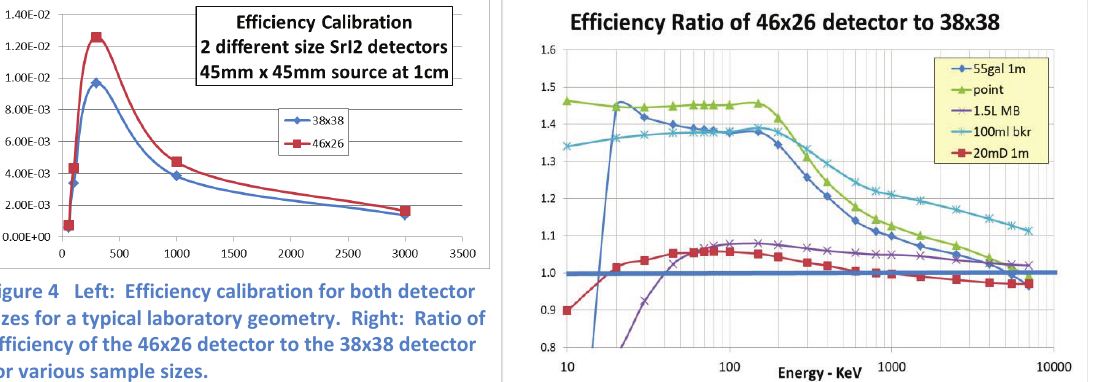
Figure 4 Left: Efficiency calibration for both detector sizes for a typical laboratory geometry. Right: Ratio of efficiency of the 46x26 detector to the 38x38 detector for various sample